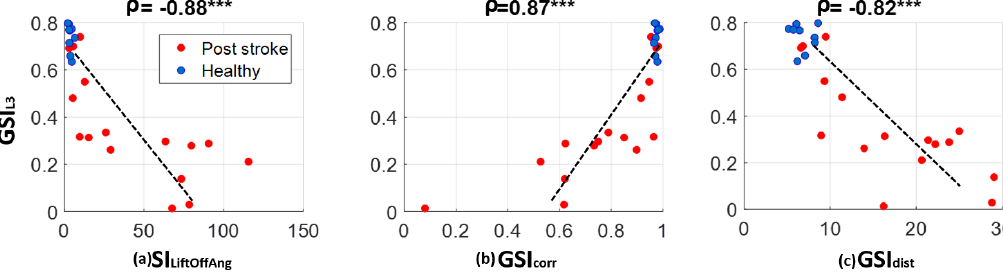
Figure 4. Correlation between gait symmetry measured with the low back accelerometer and symmetry measured with two feet sensors. Association is estimated with Spearman correlation. *** indicates p < 0.0001.